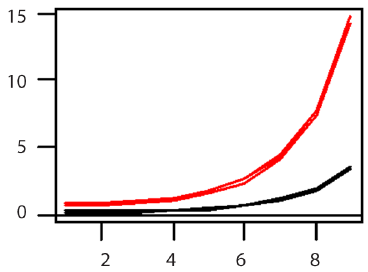
Figure 4. Impulses responses for change in GDP growth to shock in FVI. Black line denotes impulse response in low-vulnerability regime while red line denotes impulse response in high-vulnerability regime. The error band used is approximately one standard deviation as suggested by Sims and Zha